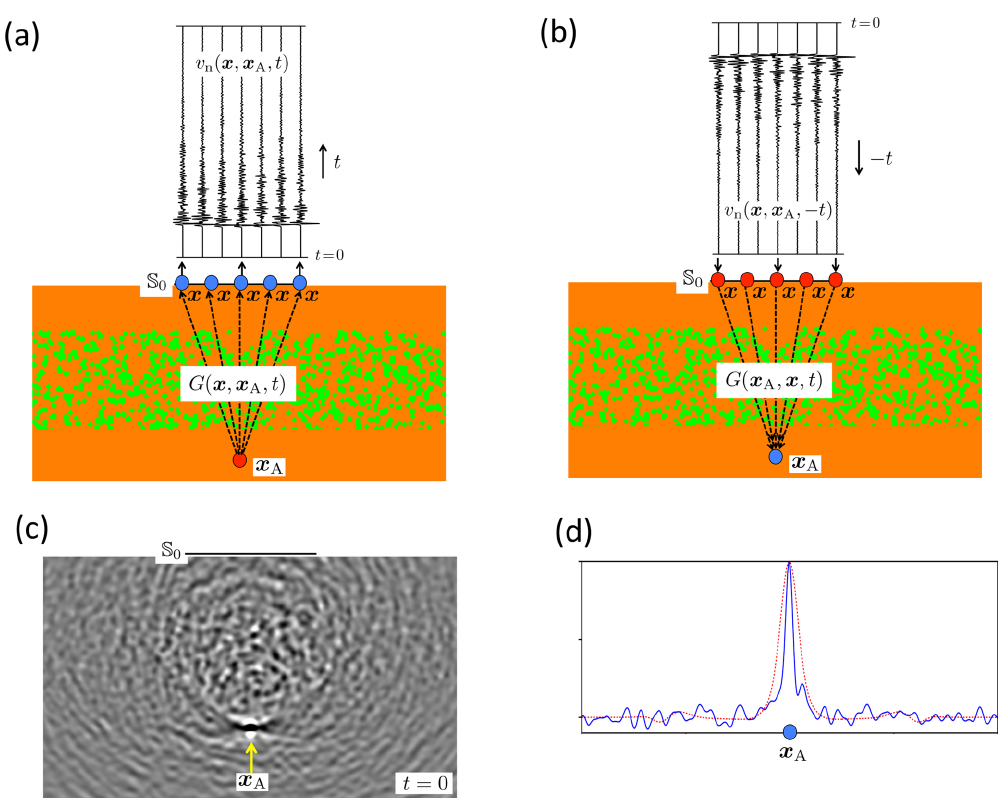
Figure 2. Principle of time-reversal acoustics. (a) Forward propagation from x A to the finite open surface S 0 . (b) Emission of the time- reversed recordings from S 0 into the medium. (c) Snapshot of the wave field at t = 0, with focus at x A . (d) Solid blue curve: amplitude cross-section of the focused field in (c) , taken along a horizontal line through the focal point x A . Dotted red curve: amplitude cross-section obtained from a similar time-reversal experiment, in the absence of